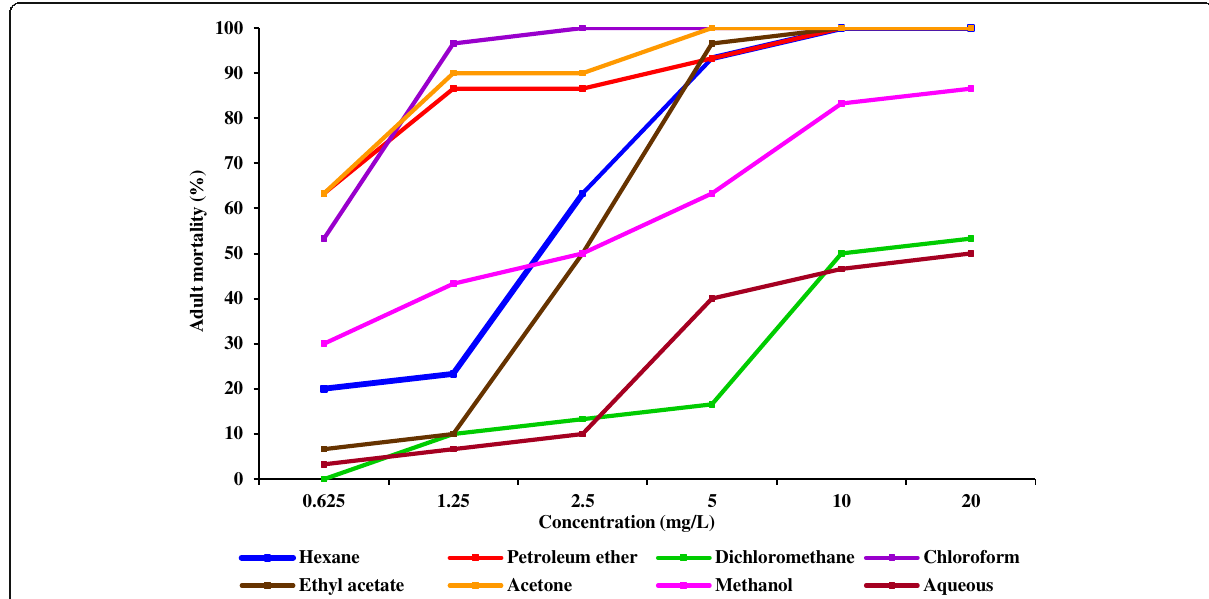
Fig. 2 Percent adult mortality of Sitophilus oryzae on exposure to Nicotiana tabacum leaf extracts at 48